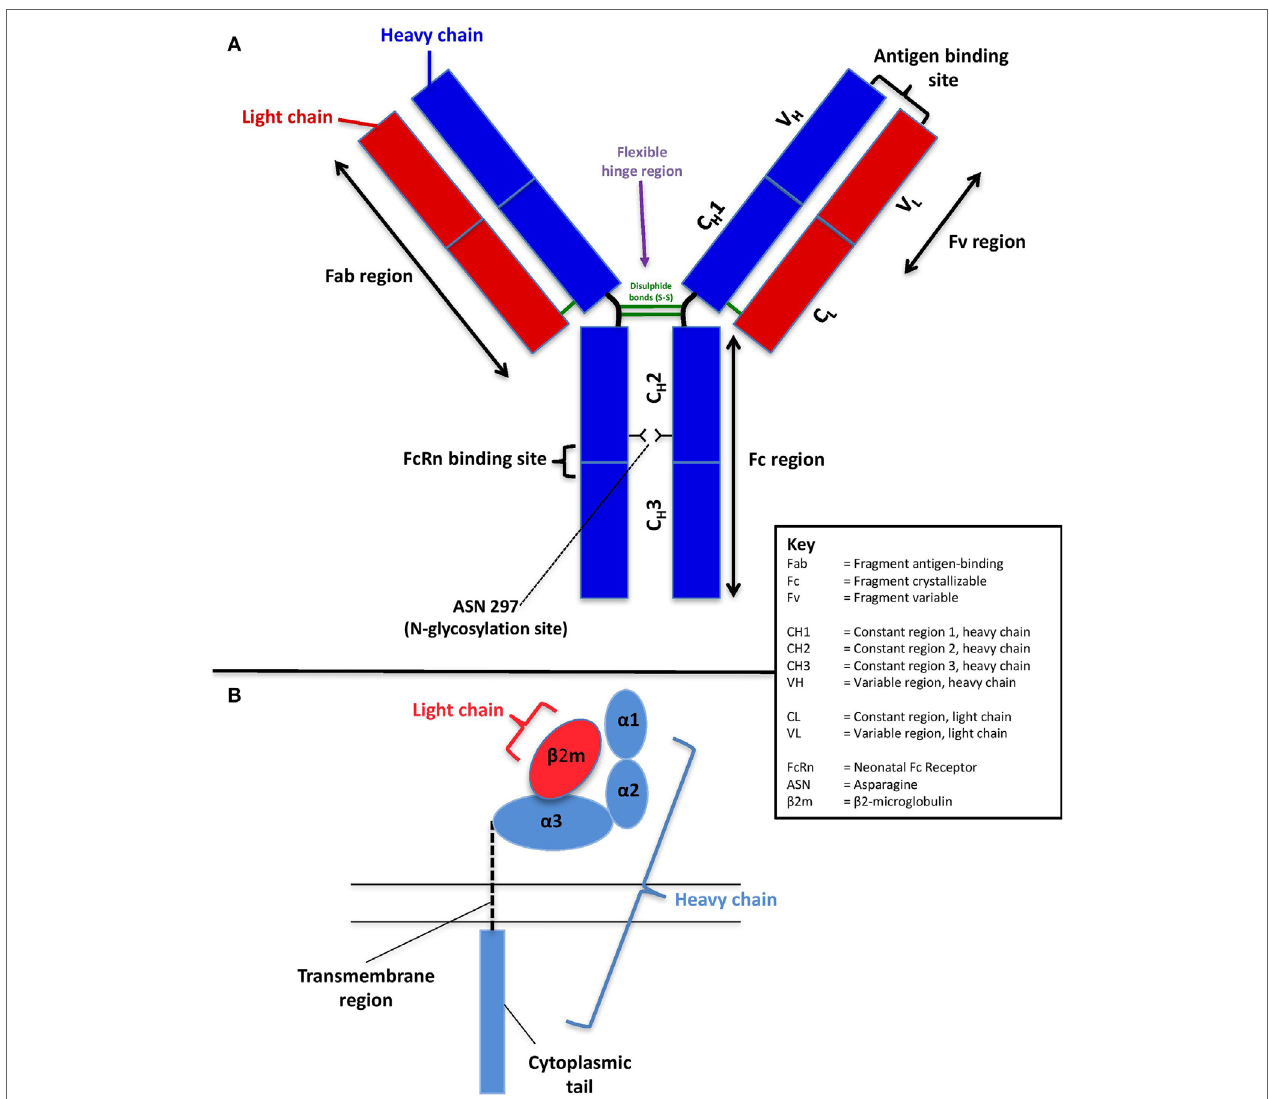
FiGURe 1 | Schematic of the structure of human immunoglobulin G (A) and the neonatal Fc receptor (B)